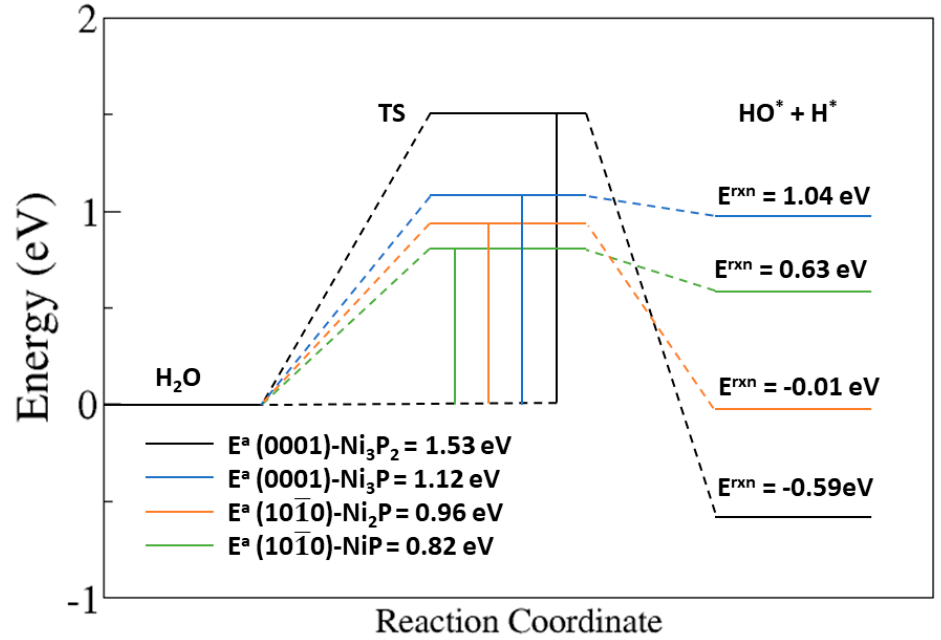
Figure 6. Activation barriers (E a ) and reaction energies (E rxn ) for dissociative water adsorption to the (0001) and (1010) surfaces of Ni 2 P.